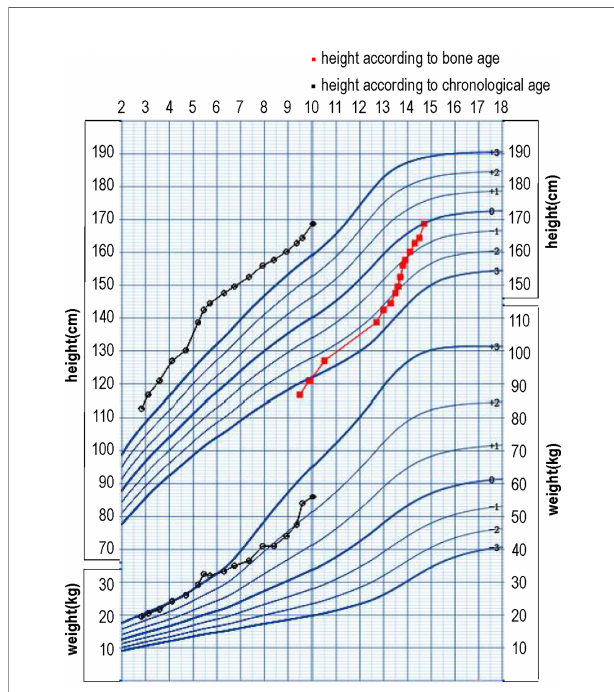
FIGURE 1 | The growth chart of the patient with height and weight, growth velocity, along with the height according to bone